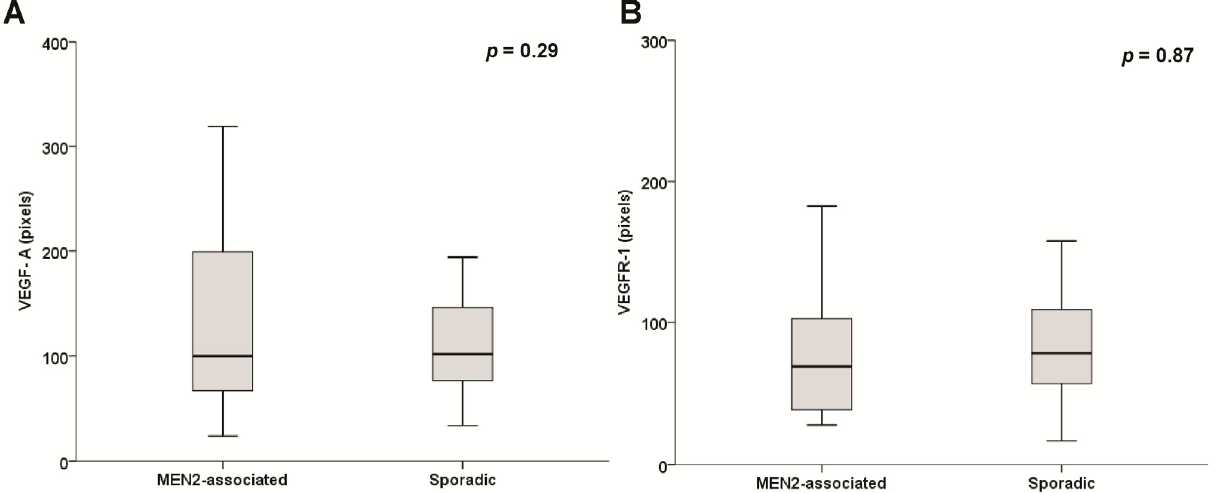
Figure 3. Immunohistochemical intensity of ( A ) VEGF-A; ( B ) VEGFR-1; ( C ) VEGFR-2; and ( D ) MVD in MEN2-associated and sporadic PHEO